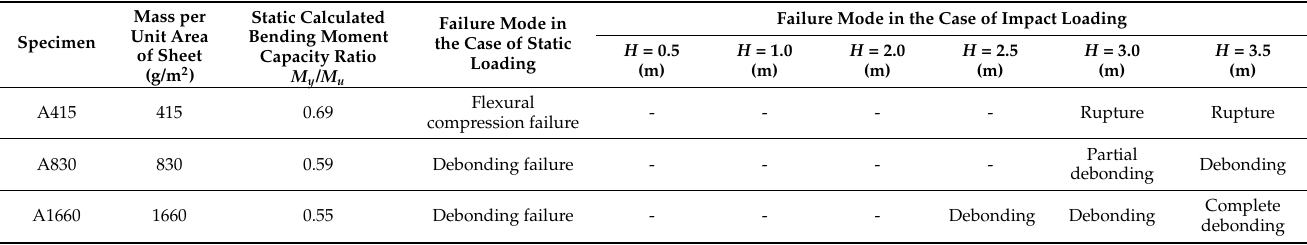
Table 7. List of the failure modes of each beam strengthened in flexure.